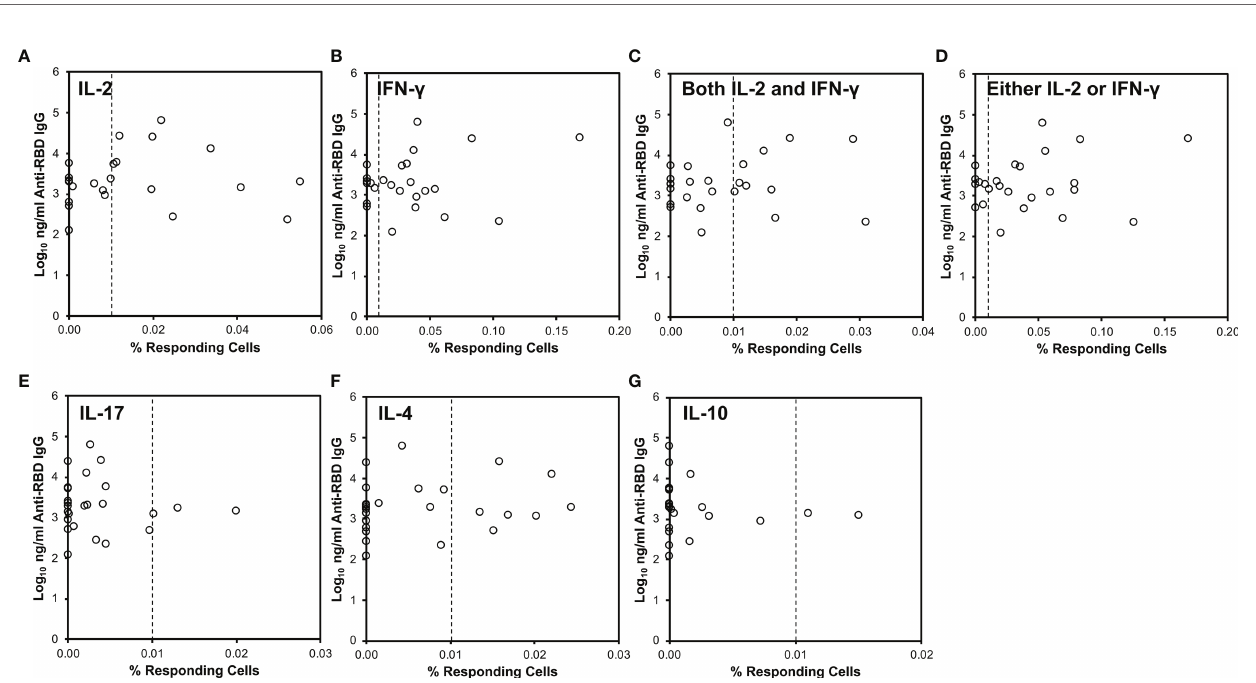
FIGURE 2 | CD4 + T cell cytokine responses against SARS-CoV-2 do not correlate to serum anti-RBD antibody levels. SARS-CoV-2-speci fi c responses de fi ned as in Figure 1 (x-axis) were compared to serum anti-RBD IgG antibody levels (y-axis). The vertical dotted line indicates 0.01% responding cells producing the indicated cytokine(s). (A) Relationship to IL-2-producing cells. (B) Relationship to IFN- g -producing cells. (C) Relationship to cells producing both IL-2 and IFN- g . (D) Relationship to cells producing either IL-2 or IFN- g or both. (E) Relationship to IL-17-producing cells. (F) Relationship to IL-4-producing cells. (G) Relationship to IL-10-producing